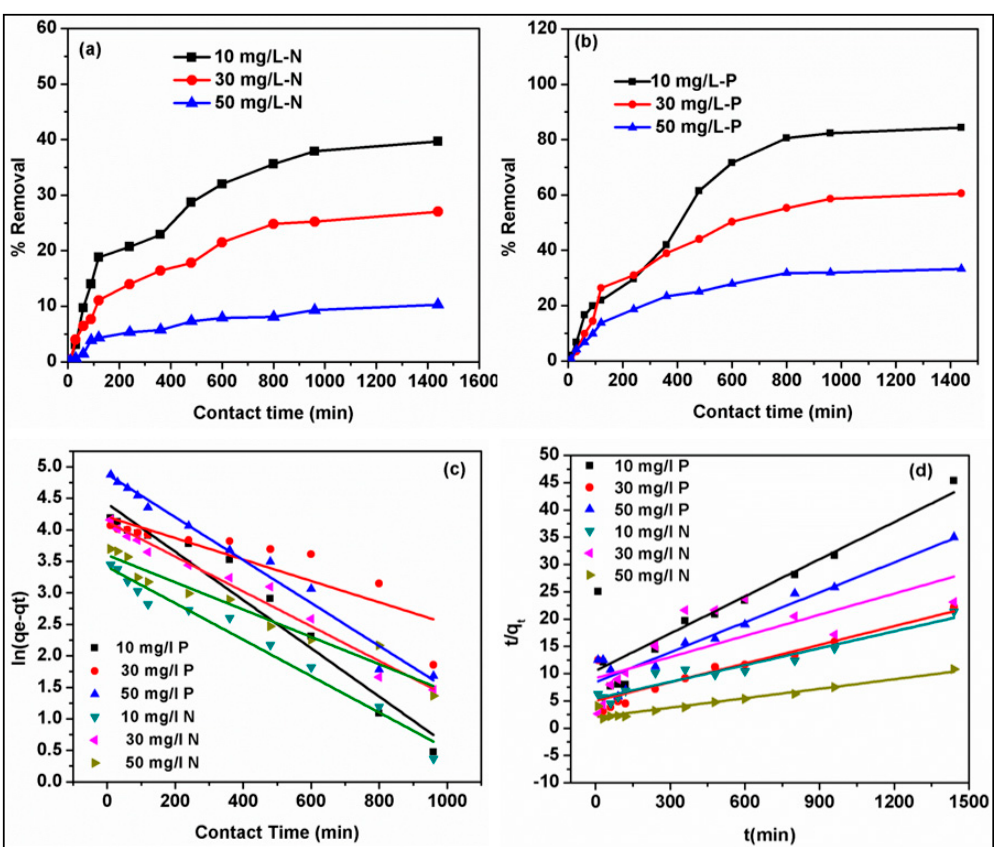
Figure 5. Rate of adsorption of nitrate and phosphate ( a , b ), linear plots of pseudo-first-order and pseudo-second-order kinetic models ( c , d ) for the removal of nitrate and phosphate onto biochar–MgAl composites. Table 3. Parameters of kinetic models for phosphate and nitrate adsorption onto B 5 MgAl composite.